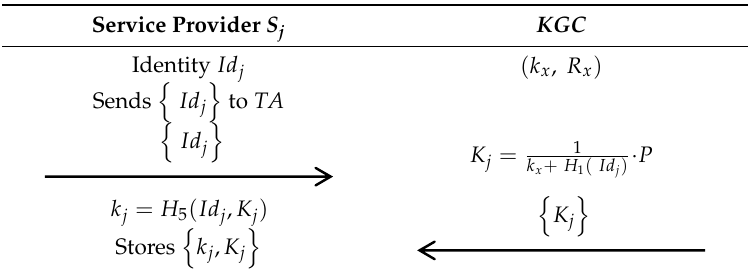
Table 8. Request and authentication phase of the proposed scheme.